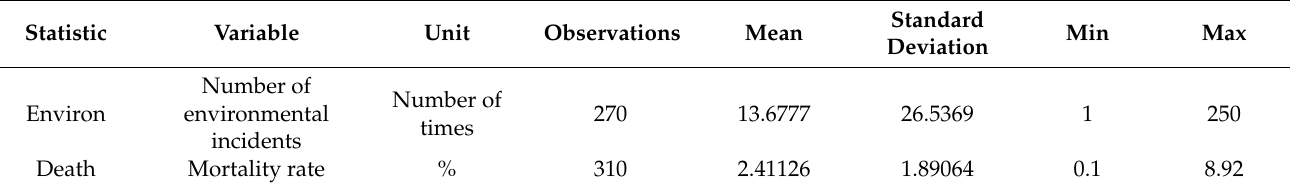
Table 3. Descriptive statistics of surrogate variables.